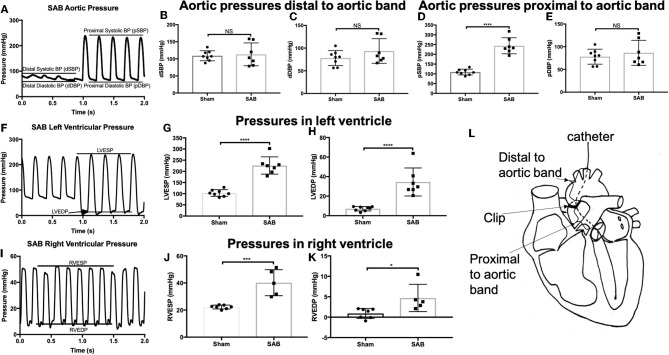
Hemodynamic studies of sham vs. SAB rats. Left carotid catheterization showing (A) hemodynamic measurement of (B) systolic, and (C) diastolic blood pressure distal to the band (dSBP and dDBP) and (D) systolic and (E) diastolic blood pressure proximal to the band (pSBP and pDBP). Left heart catheterization showing (F) hemodynamic measurement of (G) left ventricular end systolic pressure (LVESP) and (H) left ventricular end diastolic pressure (LVEDP). Right heart catheterization showing (I) hemodynamic measurement of (J) right ventricular end systolic pressure (RVESP) and (K) right ventricular end diastolic pressure (RVEDP). (L) Schematic drawing showing the anatomical definition of distal and proximal to aortic band.